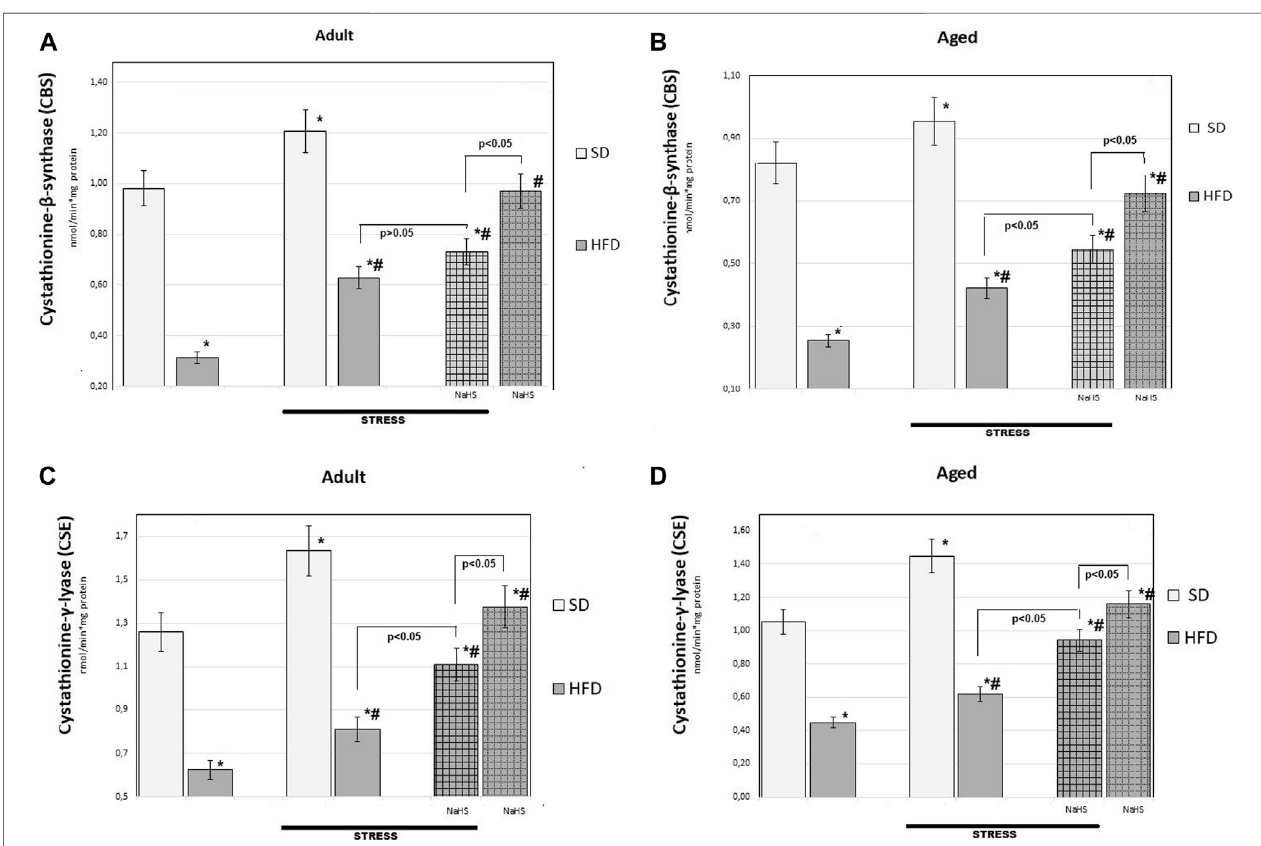
FIGURE6| Activitiesofcystathionine- β -synthase (CBS) (A,B) , cystathionine- γ -lyase (CSE) (C,D) inadult (A,C) and agedrats (B and D) ( n (cid:1) 6)fed withastandard diet (SD) or high fructose diet (HFD) without and with H 2 S releasing molecule compound therapy (NaHS) and induction of acute stress; * p < 0.05 vs. SD; # p < 0.05 vs.